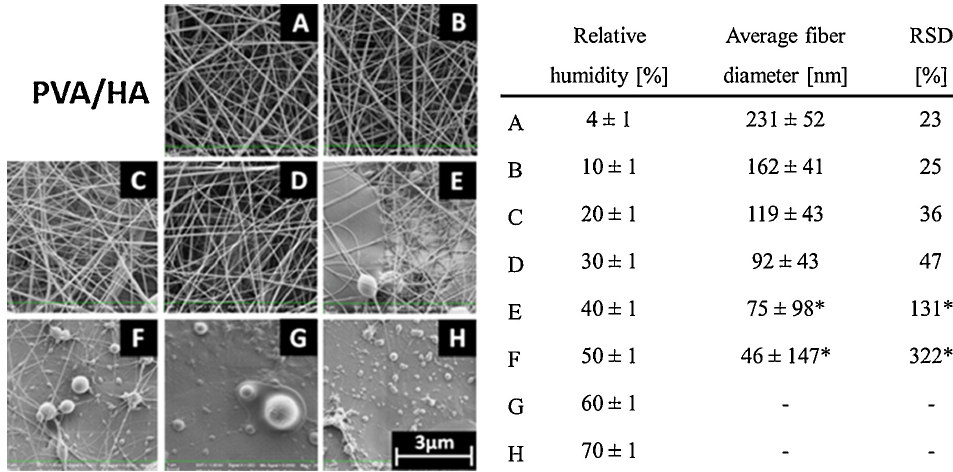
Figure 13. The FESEM images of the PVA/HA electrospun fibers, the average fiber diameter, and the fiber diameter relative standard deviation (RSD) are shown in relation to the electrospinning process’s relative humidity conditions. In addition, * indicates nanofibers with a bead morphology at higher RH rates. Reprinted with permission from ref.